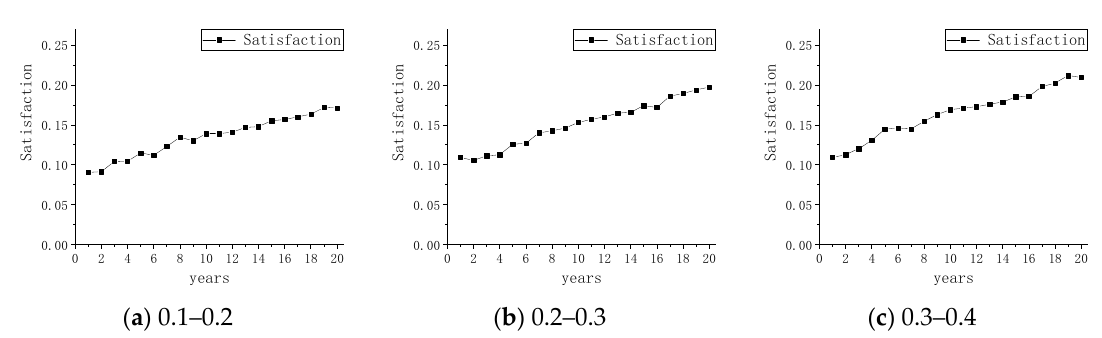
Figure 15. Satisfaction with increased coverage of safety facilities. The degree of improvement in safety livability and satisfaction is positively related to the increase in the coverage of safety facilities. By observing the trends of population changes, we found that the population changes were consistent among the three experi- ments and that significant differences did not occur. The differences were basically similar to the population changes in normal scenarios as shown in Figure 16.